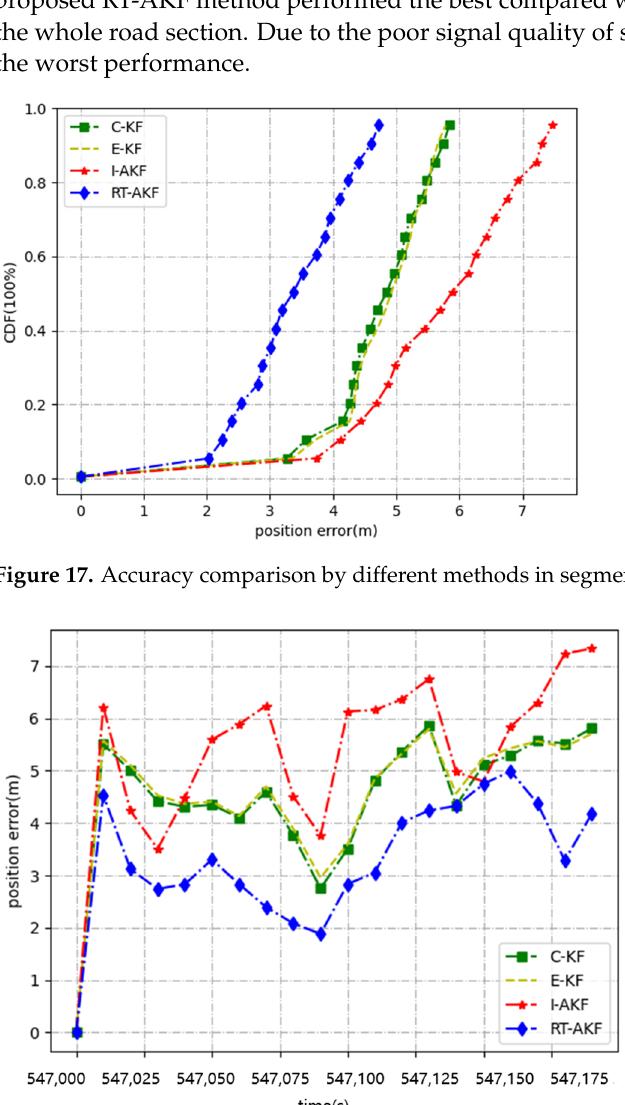
Figure 16. The positioning errors of GNSS/INS tightly coupled integrated by different methods in segment #5.